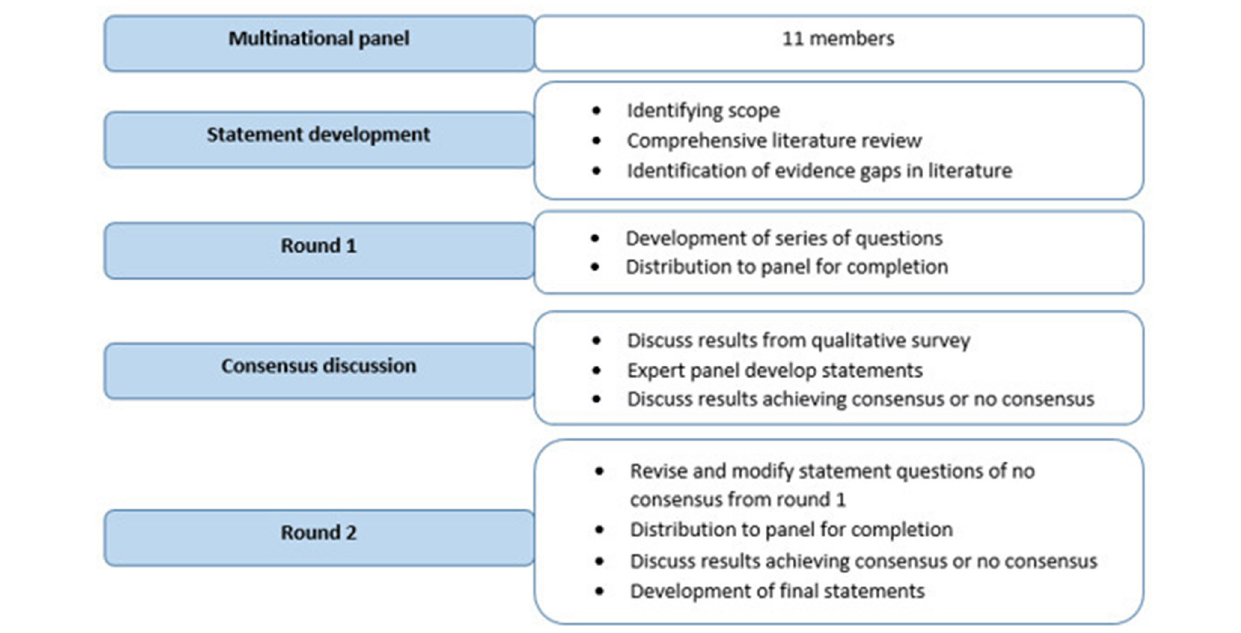
FIGURE 1 | Consensus